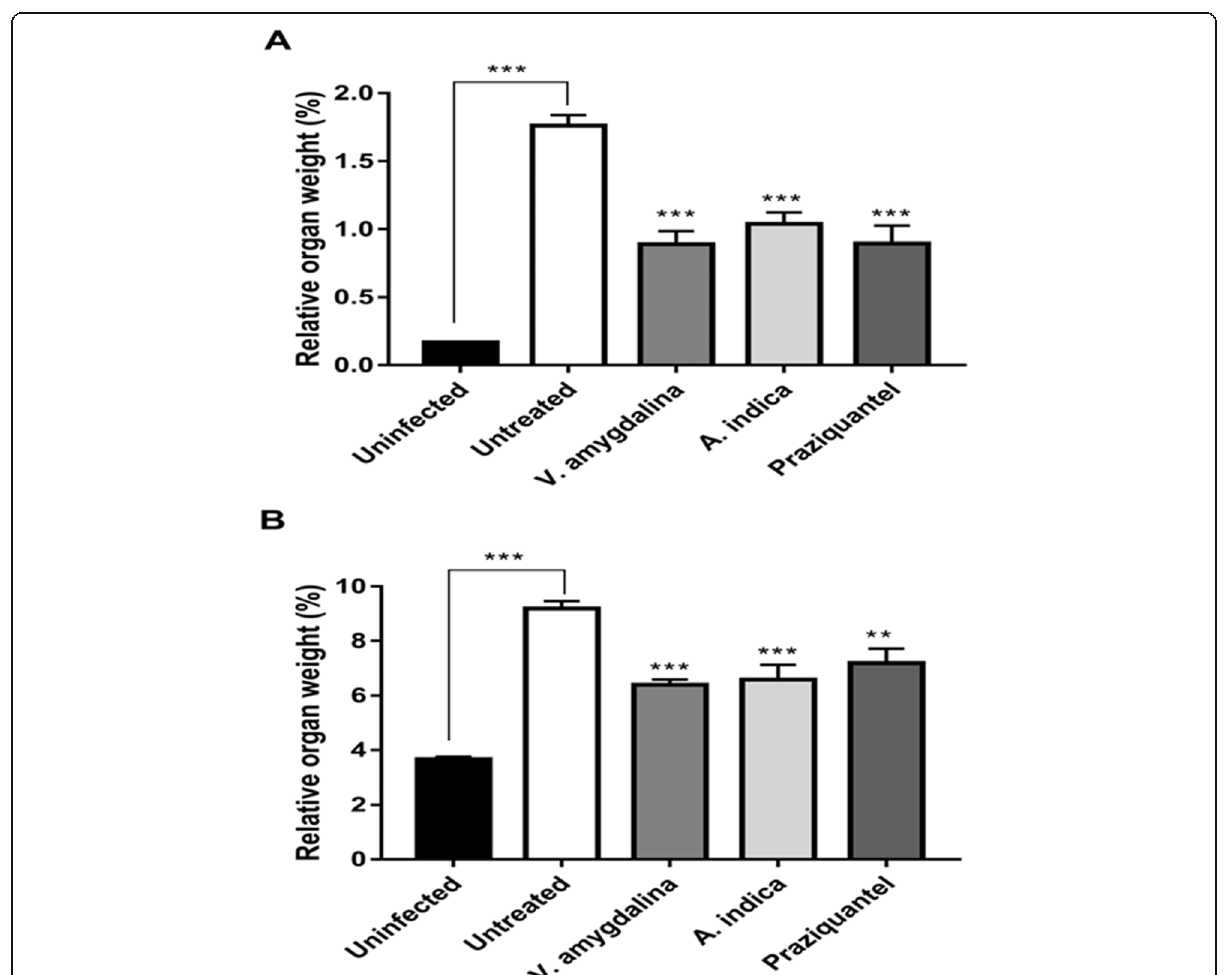
Fig. 5 Relative organ weight (%) of the various treatment